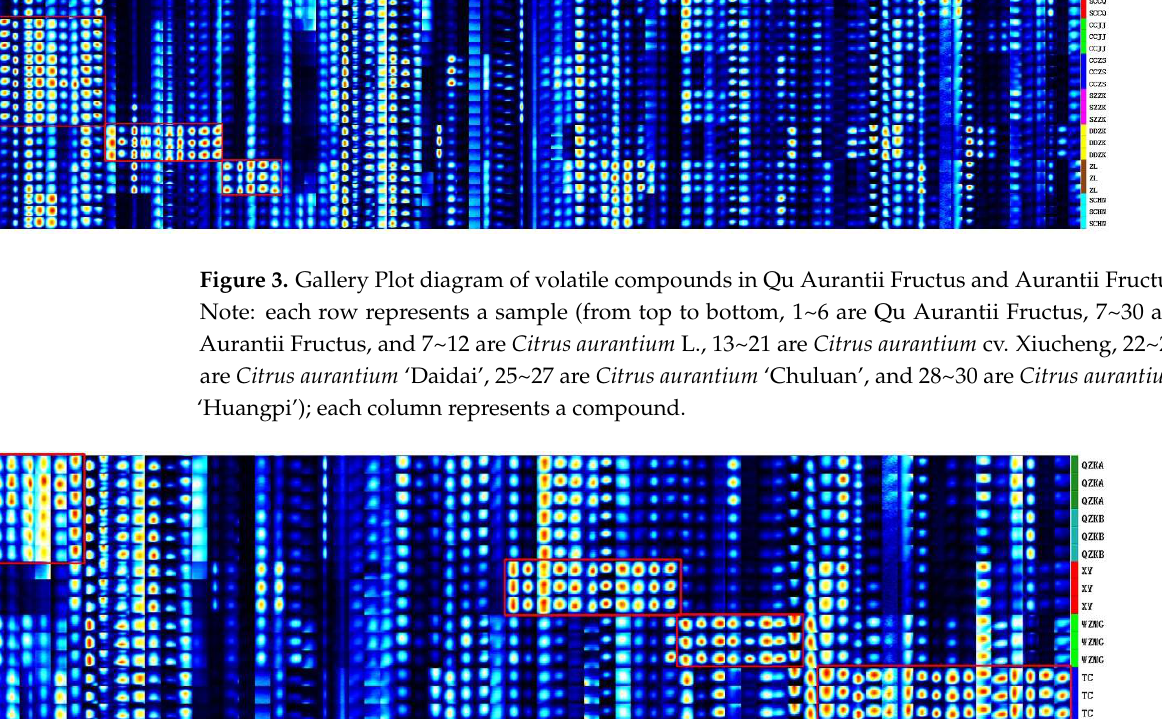
Figure 4. Gallery Plot diagram of volatile compounds in Qu Aurantii Fructus and its adulterants. Note: each row represents a sample (from top to bottom, 1~6 are Qu Aurantii Fructus, 7~9 are Citrus wilsonii Tana−ka, 10~12 are Citrus reticulata ‘Unshiu’, and 13~15 are Citrus sinensis (Linn.) Osbeck); each column represents a compound.